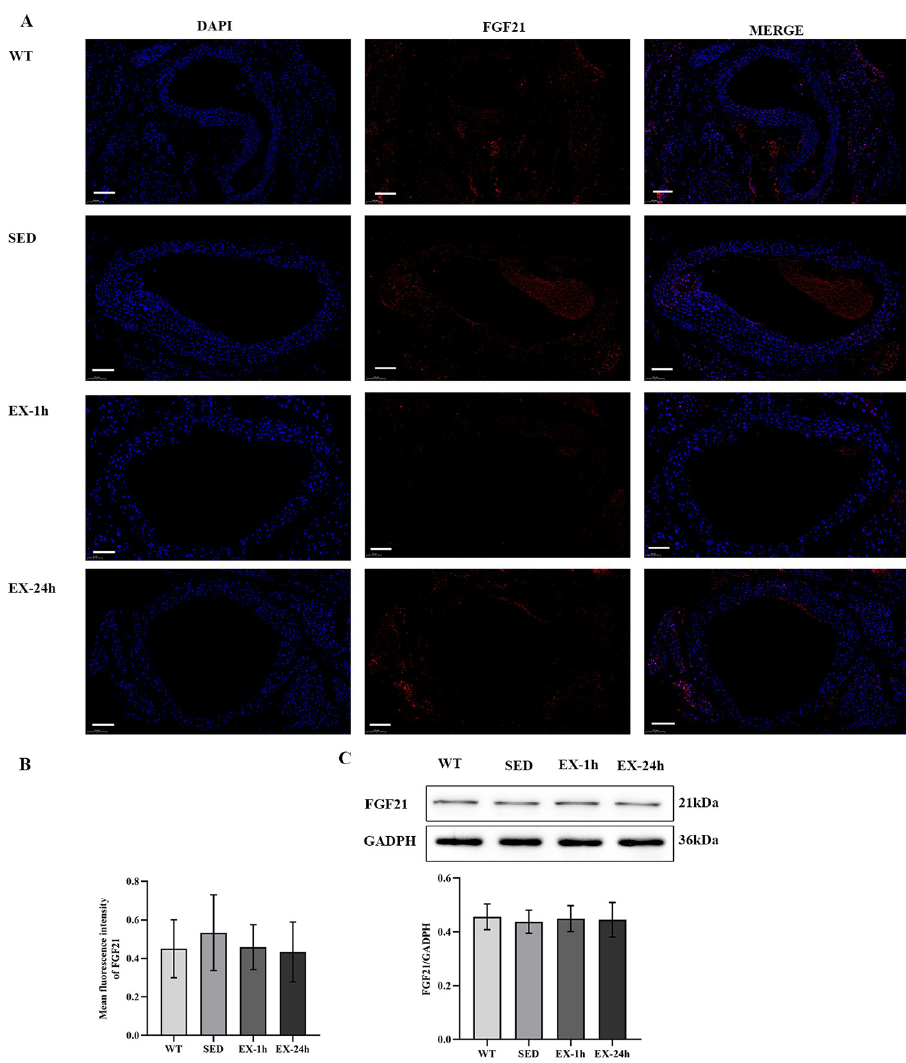
Fig 6. Aerobic exercise does not change the expression of FGF21 protein in the aorta. ( A ) The expression level of FGF21 protein in the aorta was detected by immunofluorescence. Scale bar = 100 μ m. ( B ) Analysis of the average fluorescence intensity of FGF21 in the aorta (n = 5, three slices taken from each mouse for staining). ( C ) The protein levels of FGF21 in the aorta were detected by western blotting (n = 7). Data are presented as mean ± SD of three